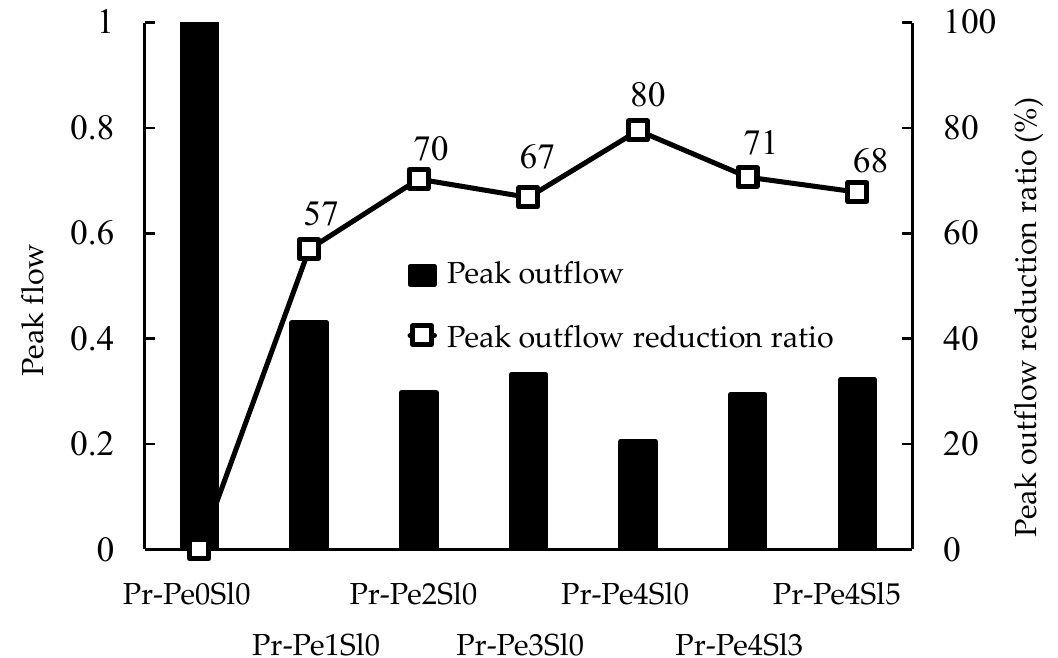
Figure 21. Results of Inflow rate.